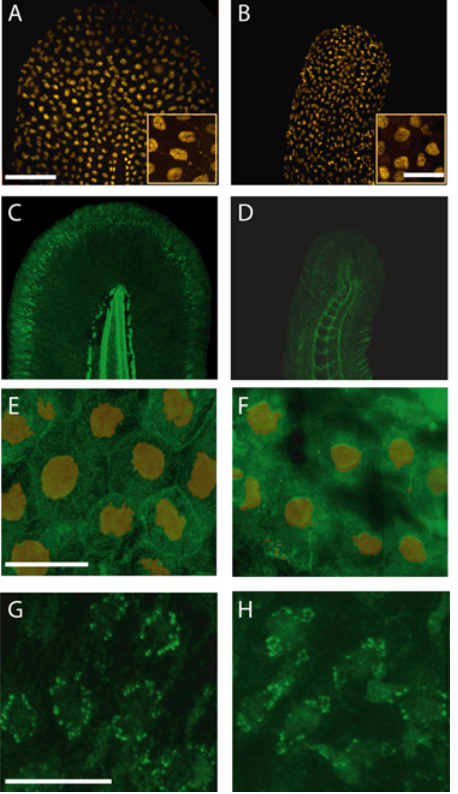
Figure 3. Ap1s1 knockdown is associated with abnormal distribution of laminin and cadherin. Despite changes in the size and shape of the tail, p63-labelled nuclei (orange) of basal keratinocytes were present in KD larvae. (B). The insets show enlarged views of small groups of keratinocytes. Immunolabelling for laminin (green) in WT (C) showed normal distribution of the basement membrane along the fin fold margin, whereas in the KD larvae the residual laminin labeling was diffuse and disorganized (D). Compared to WT keratinocytes (E) labeled with p63 (orange), cadherin (green) is decreased at the cell membrane of the KD larvae (F). However, the localization of cytokeratin in WT (G) and in KD larvae (H) appeared similar. Scale bars: 10 m m, Insets in A, B,=20 m